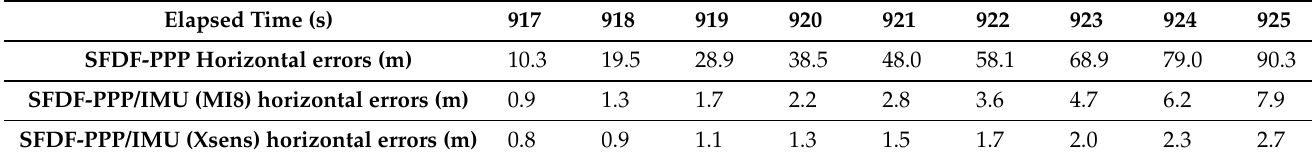
Table 8. Horizontal errors growth with different sensor fusion combinations for single- and dual- frequency PPP over Outage